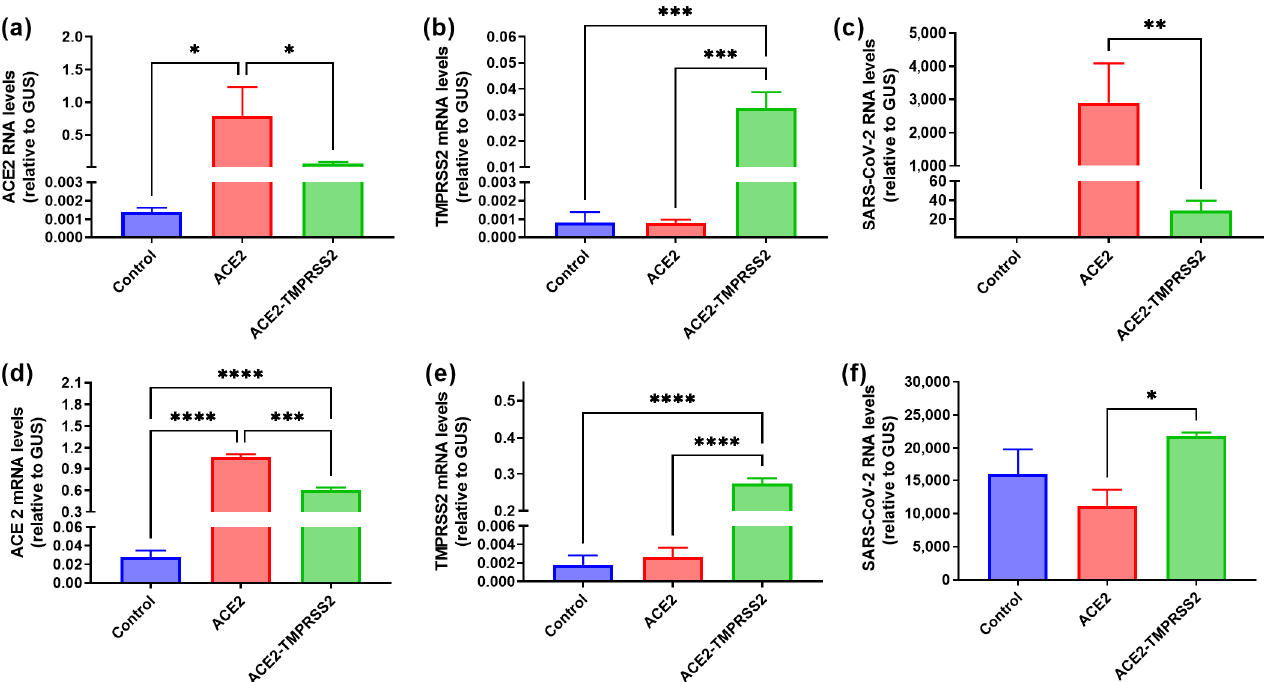
Figure 1. Overexpression of angiotensin-converting enzyme 2 (ACE2) confers the permissiveness of A549 cells to SARS-CoV-2. Naïve A549 ( a – c ) or Huh7.5 ( d – f ) cells or cells transduced by lentiviruses encoding ACE2 alone or together with TMPRSS2 were infected with SARS-CoV-2 and harvested 4 days post-infection (d.p.i.). Levels of ACE2 ( a , d ), TMPRSS2 ( b , e ) mRNA or SARS-CoV-2 RNA ( c , f ) were assessed by reverse transcription with real-time polymerase chain reaction (RT-qPCR). The levels were normalized to the levels of mRNA of β-glucoronidase (GUS). The values represent the means ± standard deviation (S.D.). * p < 0.05, ** p < 0.01, *** p < 0.001, **** p < 0.0001.